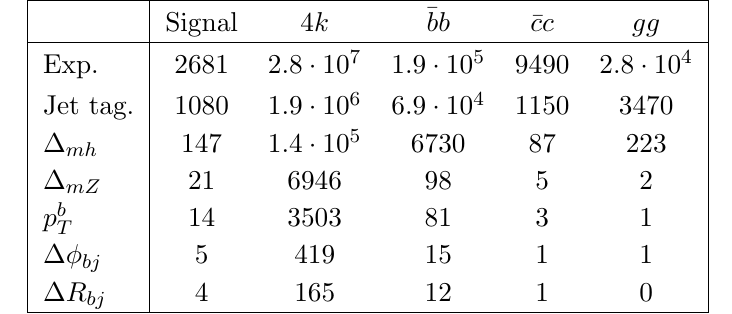
Table 2. Cut(cid:13)ow table for the signal and backgrounds in the hadronic channel at 250 GeV with polarisation sharing scenario 1 and 2 ab (cid:0) 1 of integrated luminosity. For the signal we have assumed ( h bj ) 0 : 73 B ! ’